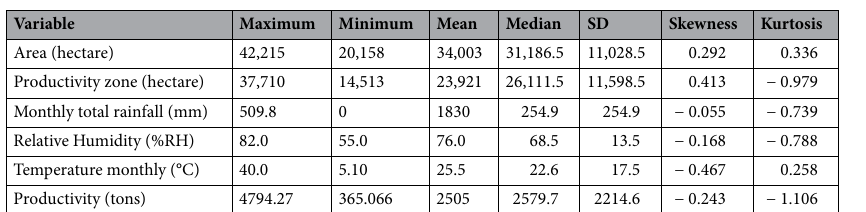
Table 1. Summary of crop yield statistics.